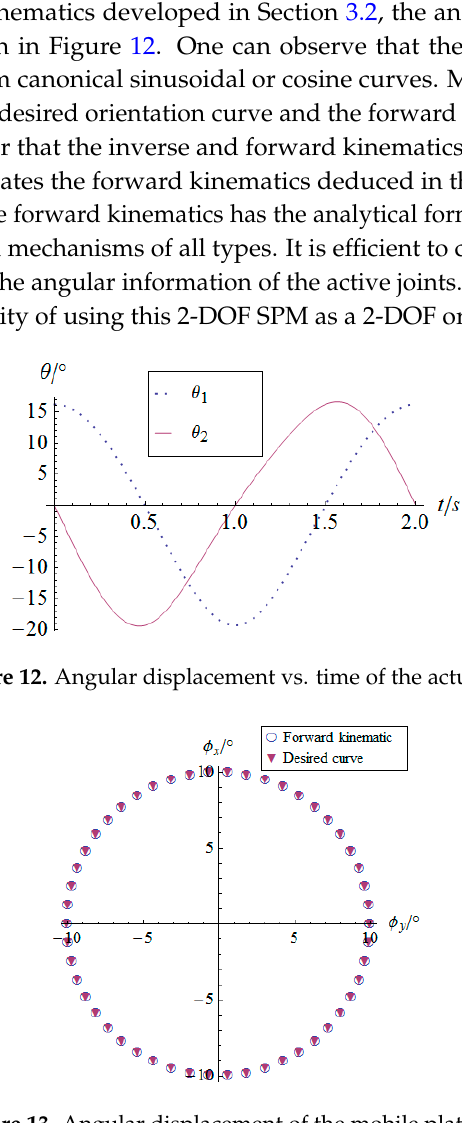
Figure 11. Driving torque vs. time of actuator 2.